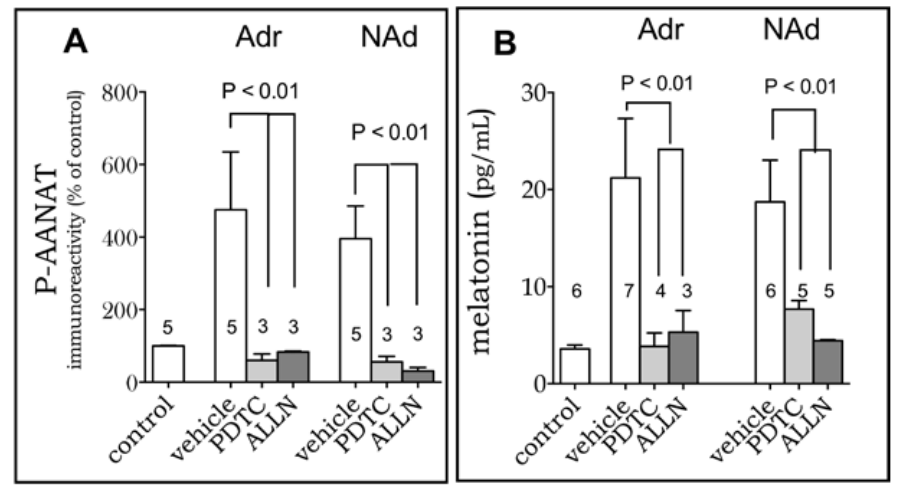
Figure 5. The transcription factor NF- κ B mediates melatonin synthesis in RAW 264.7 cells. PDTC (P, 25 µ M, 30 min) or ALLN (A, 50 µ M, 30 min) blocked Adr and Nor-induced increase in the expression of PAANAT ( A ) and melatonin production (Adr, 0.2nM; NAd, 0.4 nM, 3 h). ( B ) Data are shown as mean ± SEM; the number of replicates is shown in the graph. P-AANAT expression was normalized by the vehicle group.